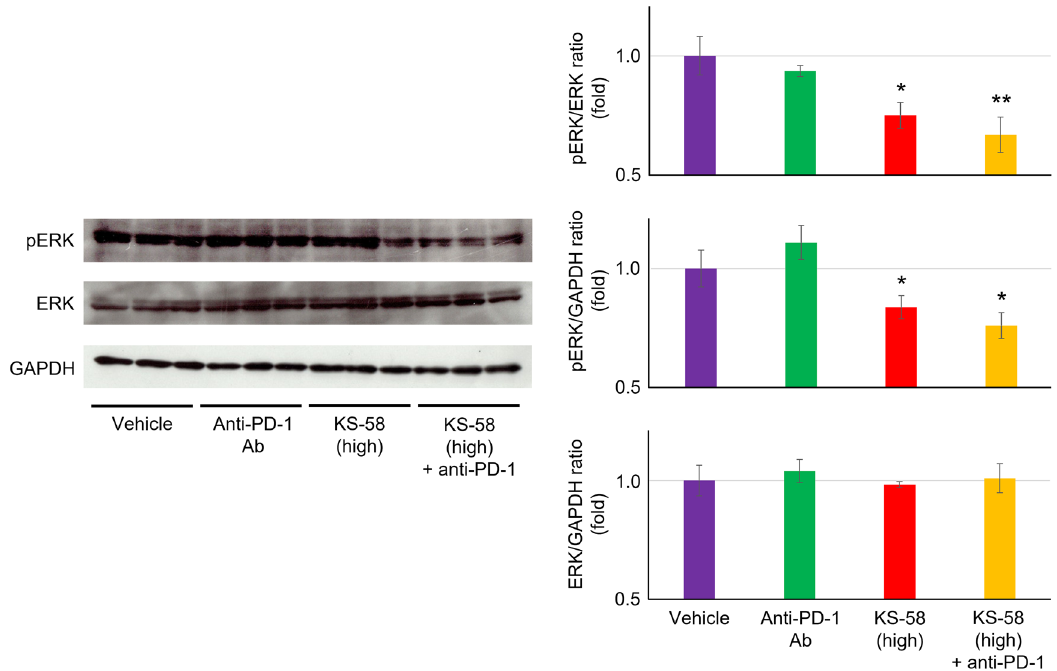
Figure 3. Inhibition of K-Ras(G12D) in CT26 cell-derived tumors by KS-58 measured using phosphorylated ERK as a biomarker. Tumors collected from major groups within 3 h after peptide or vehicle injection were homogenized, and phosphorylated ERK (pERK), total ERK and GAPDH were quantified by Western blotting. Expression levels of pERK were normalized by total ERK and GAPDH, respectively. Expression levels of total ERK was normalized by GAPDH. These expression levels are presented as the fold change relative to the vehicle group (n = 3 tumors per group, mean ± S.E.M, * p < 0.05 and ** p < 0.01 vs. Vehicle by Dunnett’s